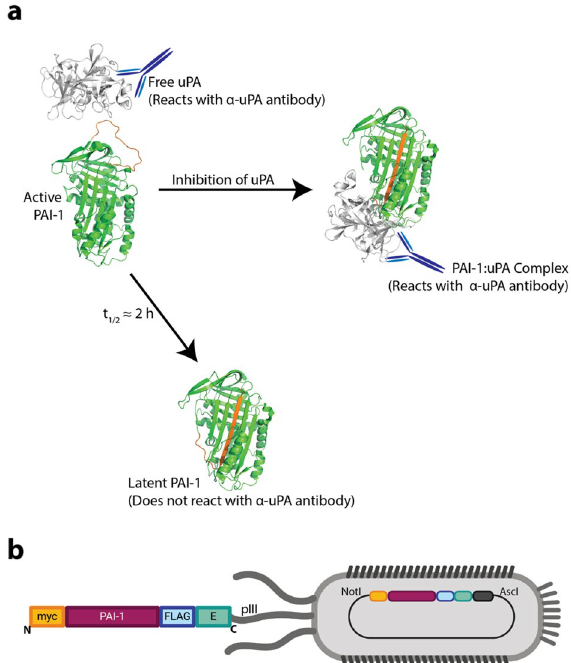
Figure 1. PAI-1 displayed as a fusion protein on the surface of filamentous phage is an inhibitor of uPA. ( a ) Active PAI-1 (PDB:3PB1) reacts with free uPA (PDB:1W0Z) to form a covalent uPA:PAI-1 complex 59,60 . Both free and complexed uPA can be immunoprecipitated using an anti-uPA antibody. Alternatively, PAI-1 can spontaneously relax from its active, metastable state to a low-energy yet chemically inert latent conformation (PDB: 1DVN) 61 . PAI-1’s reactive center loop is highlighted in orange. ( b ) Schematic of phPAI-1 displayed as a fusion to the pIII coat protein of M13 filamentous phage, with the N-terminal myc- and C-terminal FLAG- and E-tags highlighted. This figure was generated using Adobe Illustrator 2021 version 25.2.3 ( a , b ), PyMOL version 2.5.0 ( a ), and BioRender.com ( b